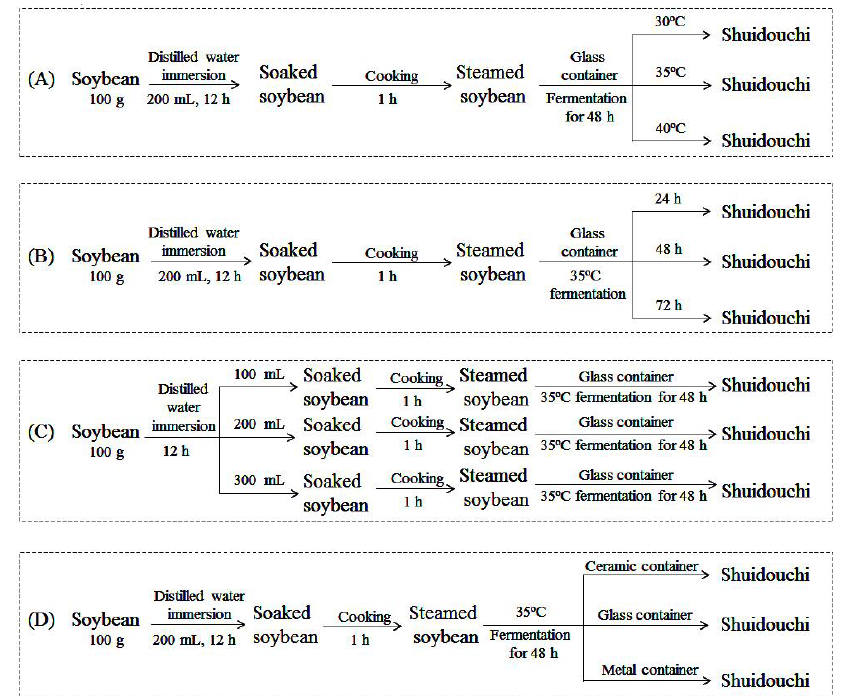
Figure 1. Technological design of Shuidouchi. ( A ) Soybeans fermented at different temperatures; ( B ) Soybeans fermented for different durations; ( C ) Soybeans fermented in different quantities of soaking water; and, ( D ) Soybeans fermented in different containers.